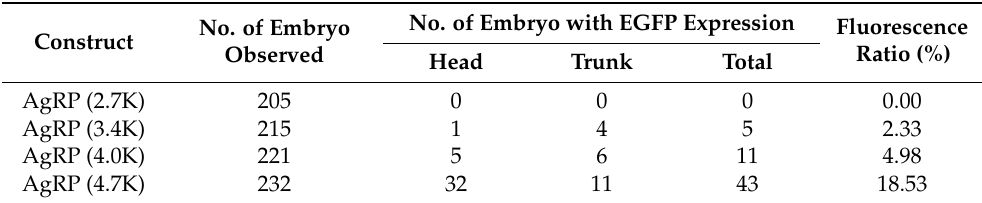
Table 1. Expression of EGFP in 36 hpf embryos injected with constructs containing the agrp pro- moter